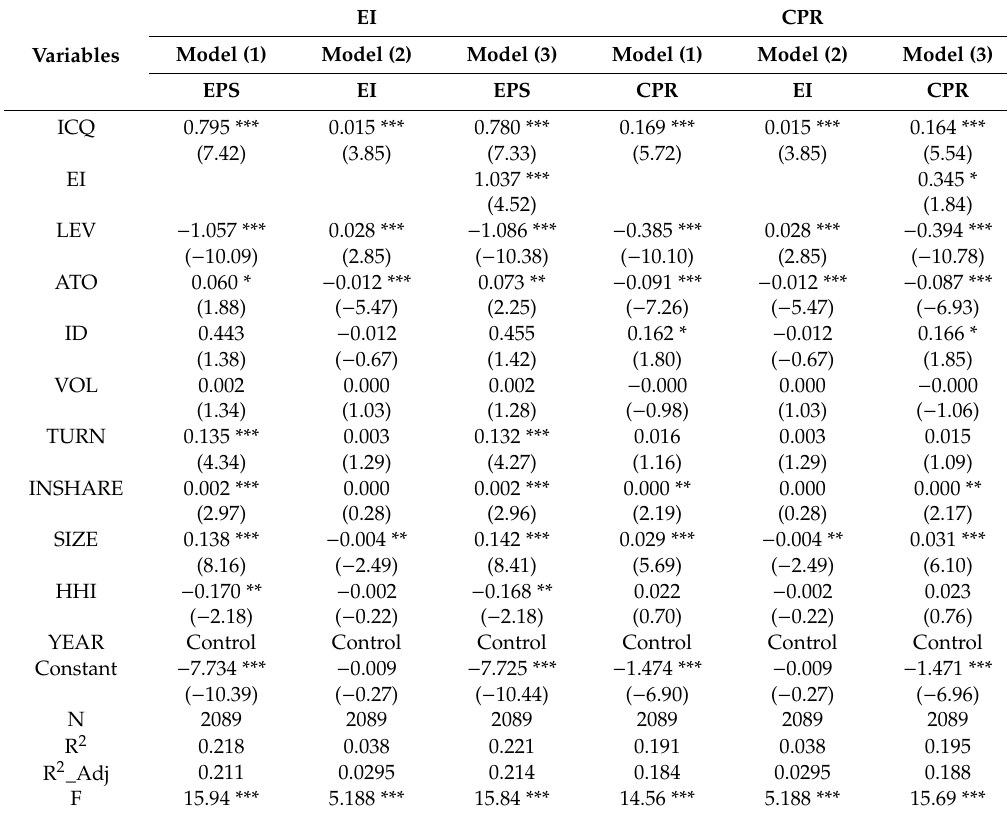
Table 5. Robustness test (Alternative